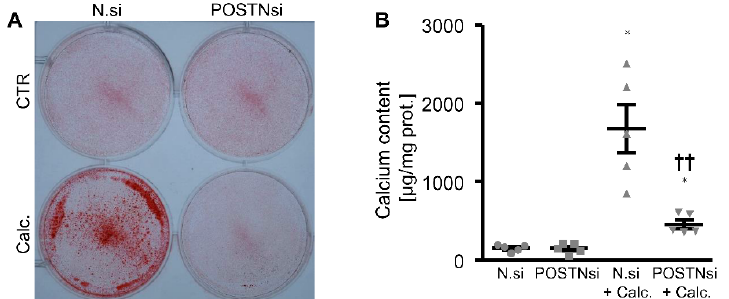
Figure 7. Silencing of periostin reduces phosphate-induced calcification of HAoSMCs. ( A ) Alizarin Red staining in HAoSMCs transfected with negative control siRNA (N.si) or POSTN siRNA (POSTNsi) and treated with control (CTR) or calcification medium (Calc.). Calcified areas: red staining. ( B ) Calcium content in HAoSMCs transfected with negative control siRNA (N.si) or POSTN siRNA (POSTNsi) and treated with control (CTR) or calcification medium (Calc.). * p < 0.05 (significant difference versus N.si group); †† p < 0.01 (significant difference versus N.si + Calc.